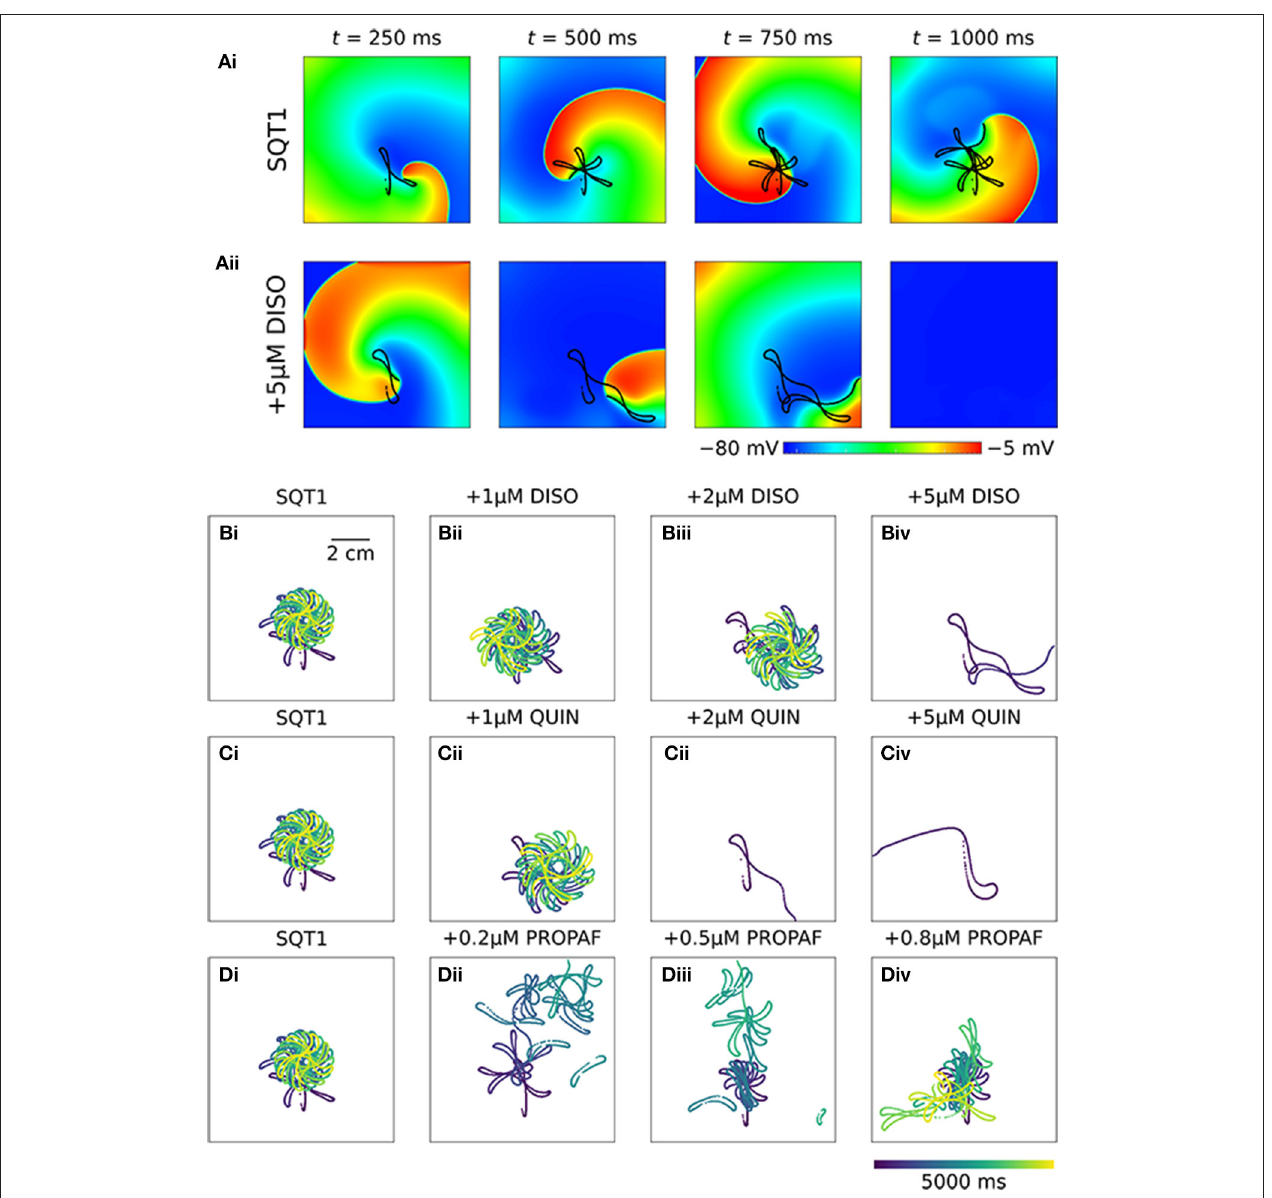
FIGURE 6 | Re-entry dynamics in homogeneous 2D sheets upon application of disopyramide, propafenone, and quinidine in SQT1 mutation conditions. (A) Representative snapshots of re-entrant spiral waves under (i) drug-free SQT1 and (ii) SQT1 + 5 µ M disopyramide (DISO) conditions at times, t = 250, 500, 750, and 1,000ms following re-entry initiation, with spiral wave core trajectories superimposed onto membrane potentials in black. Spiral wave core trajectories over a 5,000ms period under (Bi, Ci, Di) drug-free SQT1 conditions, and upon application of (Bii) 1 µ M, (Biii) 2 µ M, and (Biv) 5 µ M DISO, (Cii) 1 µ M, (Ciii) 2 µ M, and (Civ) 5 µ M quinidine (QUIN), and (Dii) 0.2 µ M, (Diii) 0.5 µ M, and (Div) 0.8 µ M propafenone